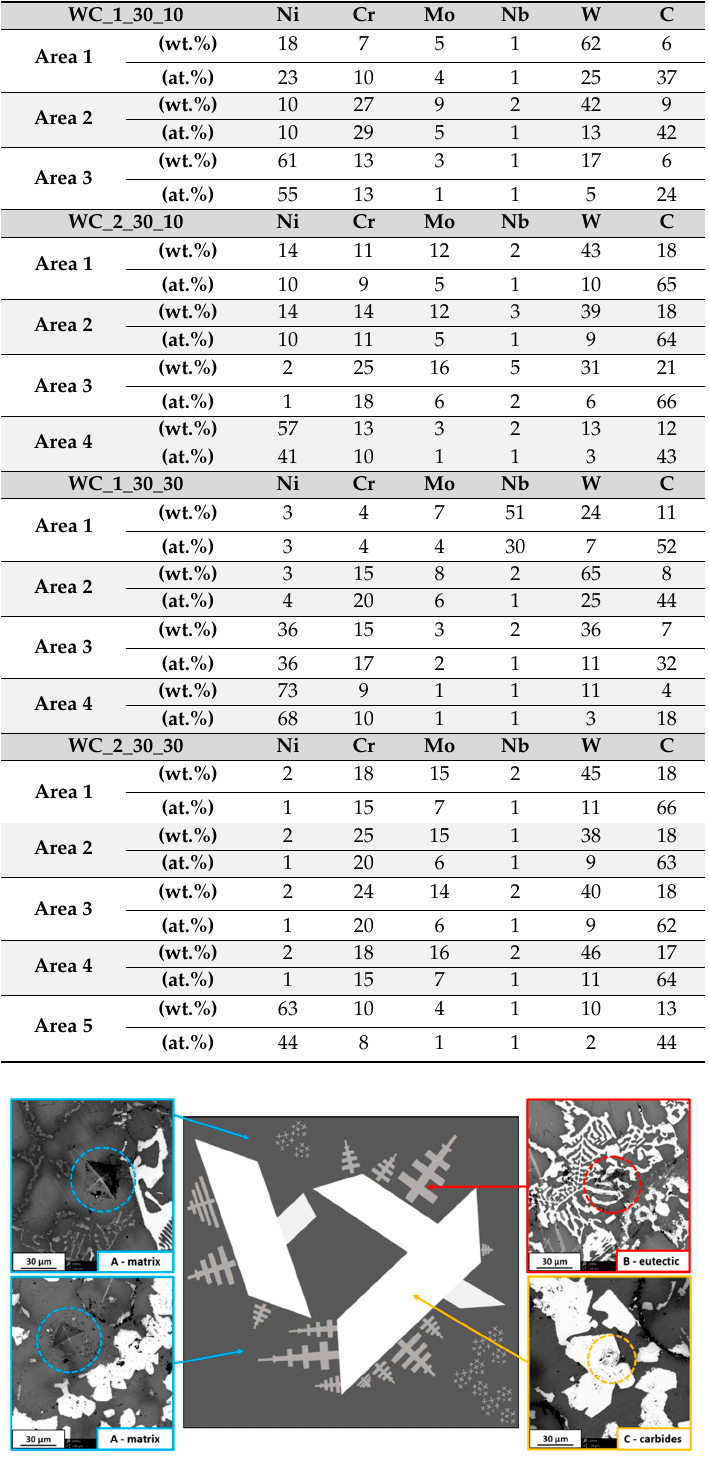
Figure 8. Schematic representation of observed phases with additional SEM images showing typical appearance of hardness test indents in different phases.